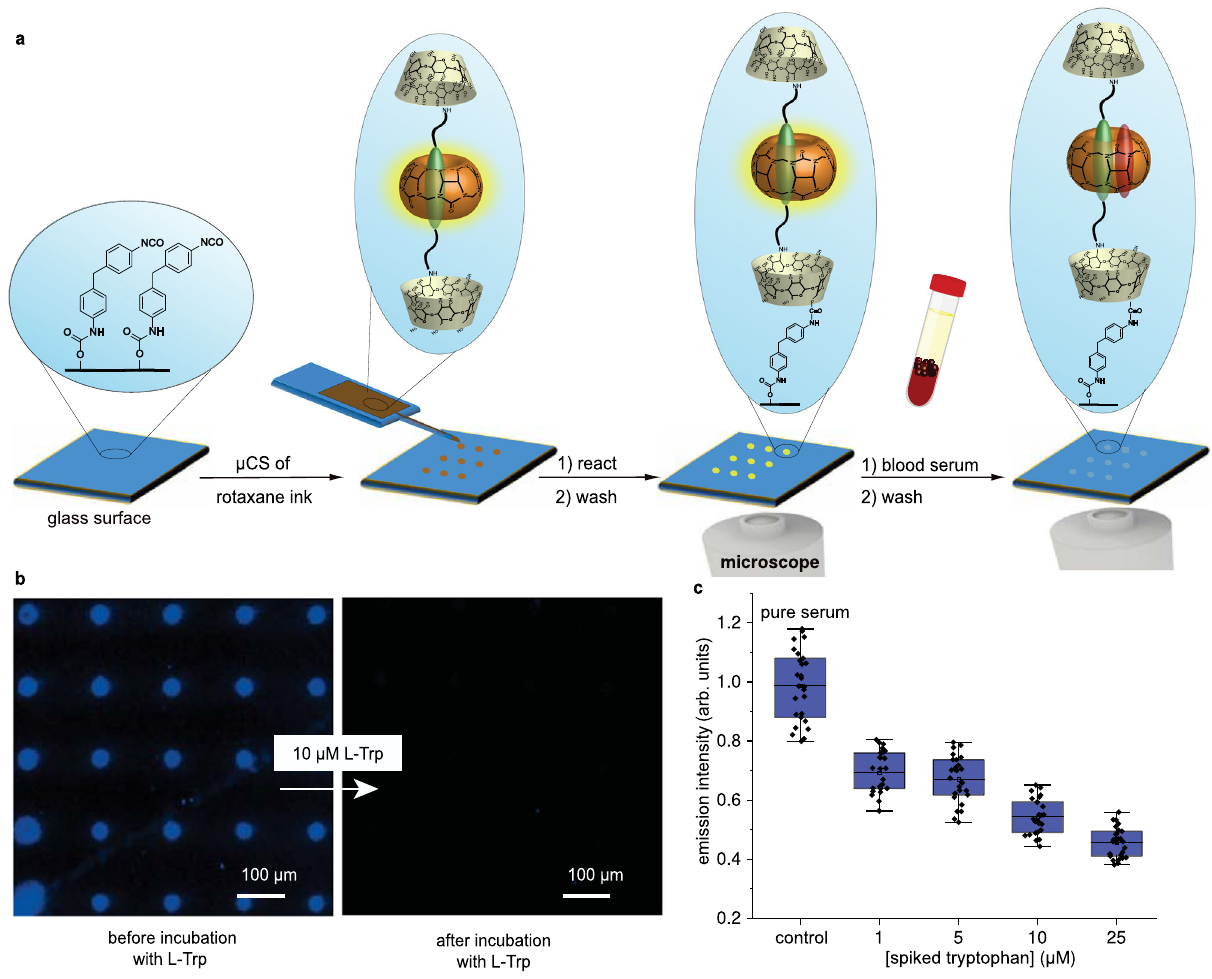
Fig. 6 | Immobilization of rotaxane 1 on glass surfaces by µ CS. a Schematic representation of microarray printing of rotaxane 1 via microchannel cantilever spotting ( µ CS) on an isocyanate-covered surface and analyte detection by micro- arrays. b Fluorescence microscopy images (DAPI fi lter, λ ex =395nm, 10seconds exposure time) of a microarray before and after incubation with 10 μ M Trp in 1X PBSshowedastrong emissiondecrease,measured in n =3independent replicates. c Box plot of the emission intensity for a sensor chip prepared by µ CS of 1 after